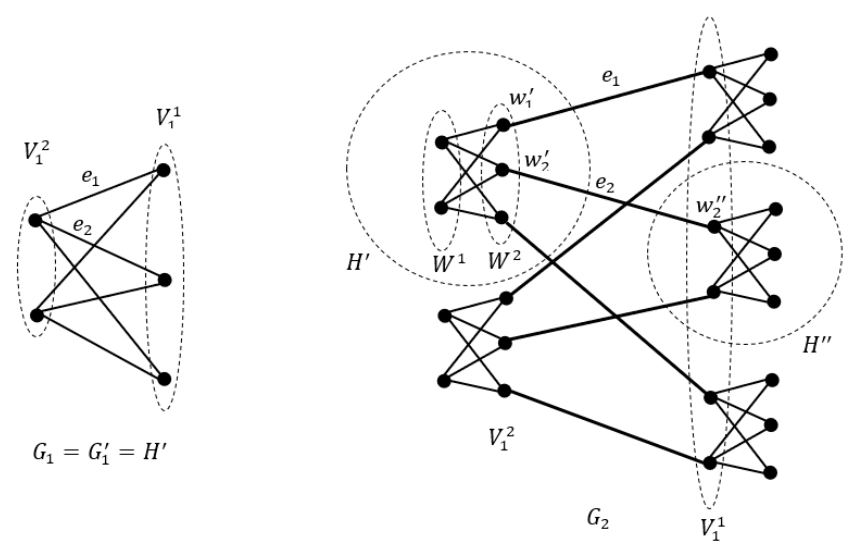
Figure 9. Prefractal graph G 2 generated by a complete bipartite seed; old edges are not adjacent. For each graph (cid:1833) (cid:3039) with an arbitrary adjacency of old edges, it is possible to select a